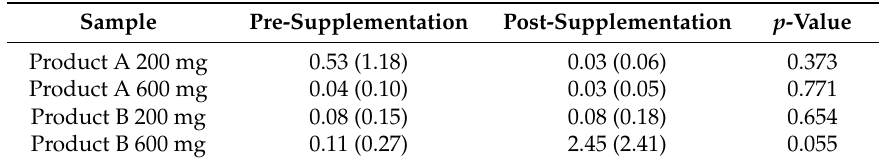
Table 2. Bovine faecal lactoferrin content ( µ g/g) pre and post supplementation dependent on Product and dose, and significance between time points. * p <